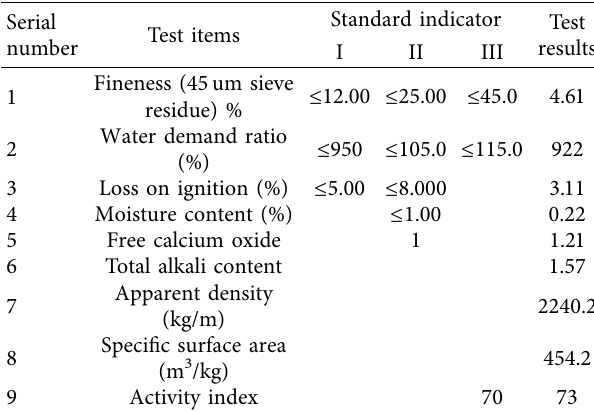
Table 5: Technical indicators and test results of fly